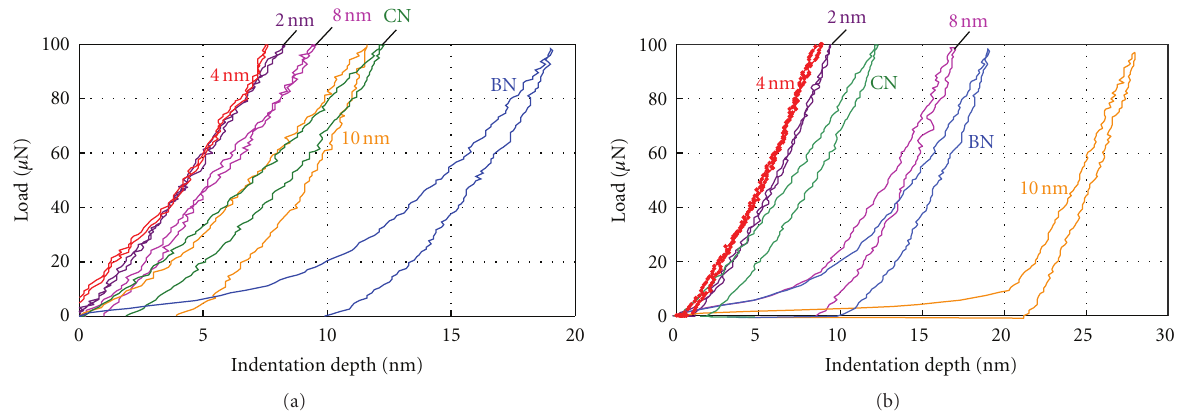
Figure 5: Nanoindentation curves of (a) (CN/BN)n and (b) (BN/CN)n films.